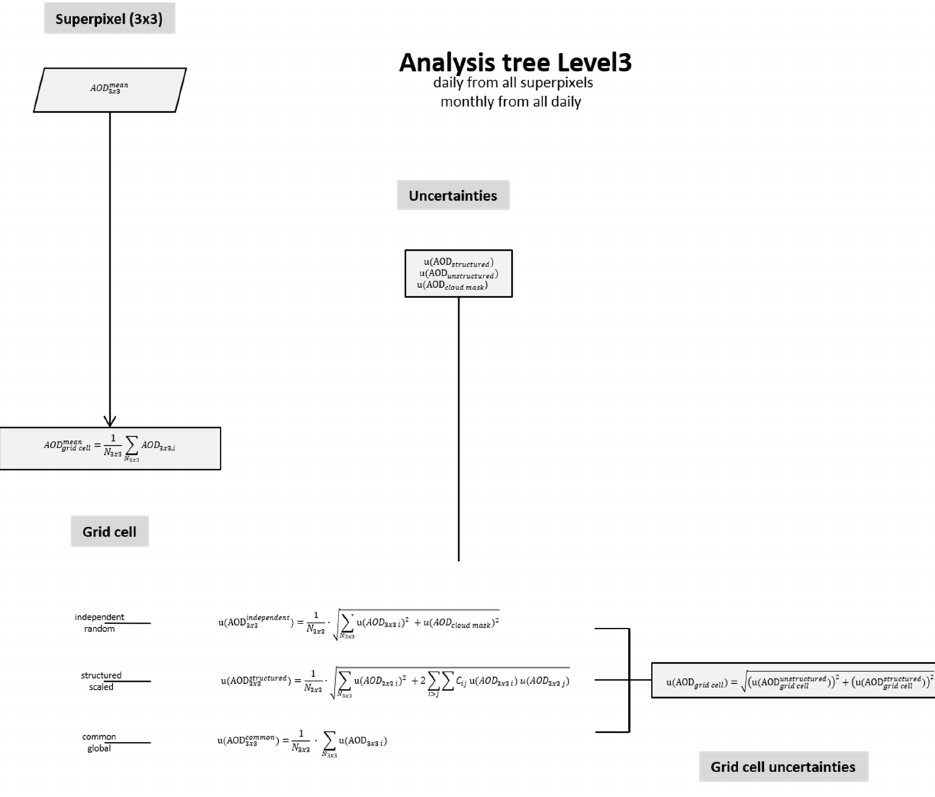
Figure 4. L3 analysis tree for AVHRR AOD.